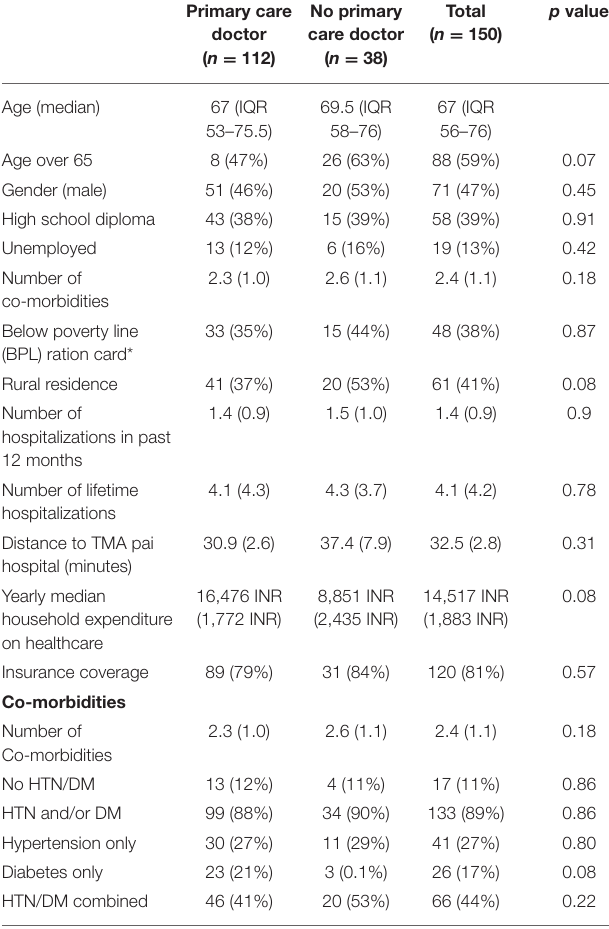
TABLE 2 | Socio-demographic factors and co-morbidities of patients by PCP status.